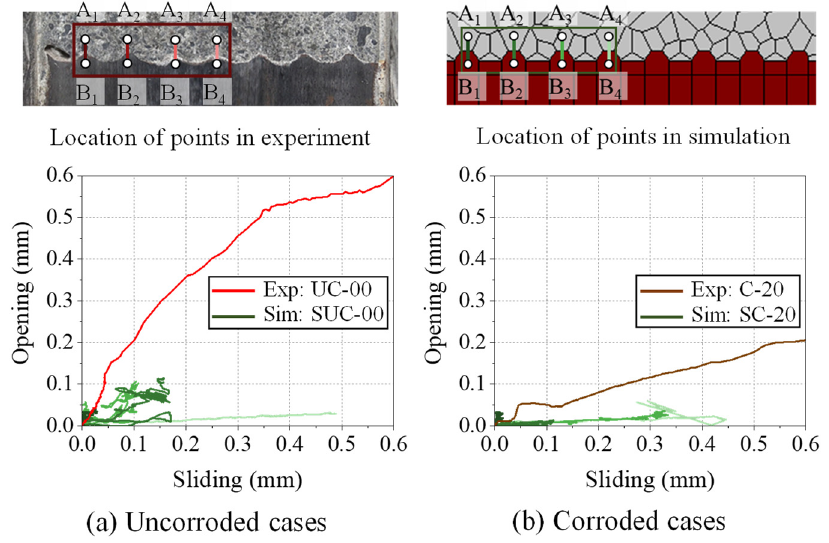
Figure 11. Location of points and opening-sliding relationship observed in the experimental simula- tion study for.